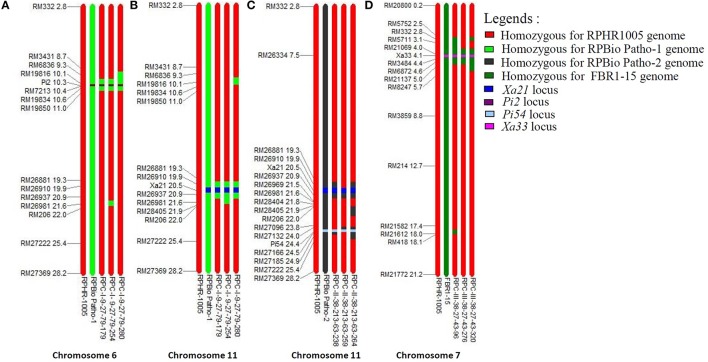
Analysis of genome introgression associated with the blast resistance gene, Pi2 on chromosome 6 (A) and BB resistance gene, Xa21 on chromosome 11 (B) in the best backcross plant (# RPC-I-9-27-79-179) of RPHR-1005, possessing Xa21 + Pi2 indicating a donor segment introgression, limited to ~1.4 Mb. (C) Analysis of genome introgression associated with the both Xa21 and Pi54, a genomic region limited to ~1.3 Mb has been only introgressed from the donor parent (RPBio Patho-2) in the best backcross plant (i.e., plant # RPC-II–38-213-63-259; possessing Xa21 + Pi54). (D) Analysis of genome introgression associated with the Xa33, a genomic region limited to ~1.0 Mb has been only introgressed from the donor parent (FBR1-15) in the best backcross plant (i.e., plant # RPC-III-38-27-43-276; possessing Xa33). The position of the polymorphic SSR markers in Mb on Chr. 6, 11, and 7 is given in parenthesis adjacent to each marker, while each marker has also been positioned with respect to each other in terms of cM scale.